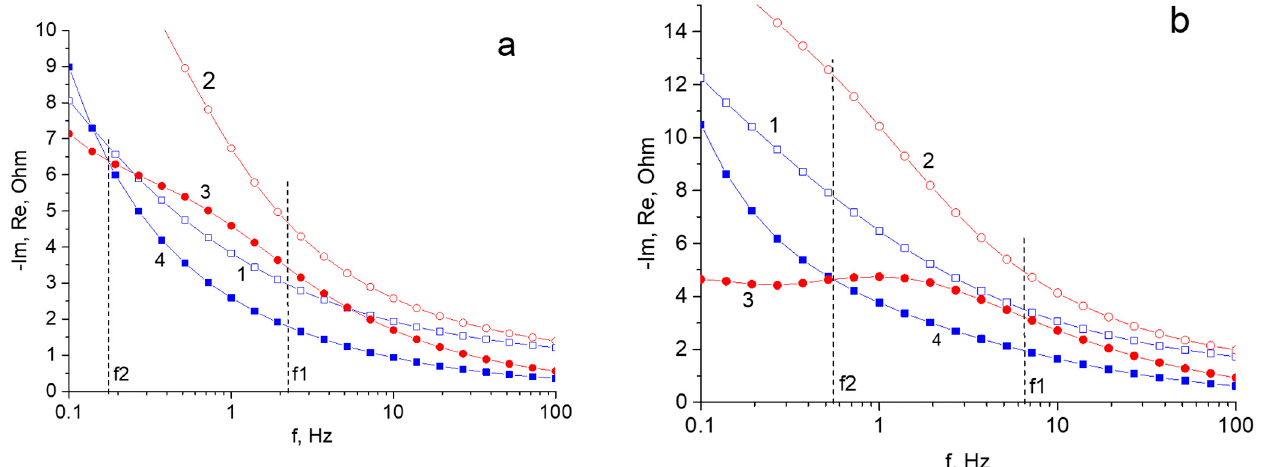
Figure 12. ( a ) Region of Bode diagram (from 100 Hz to 0.1 Hz) for the rGO/TiO 2 15% composite: 1—(Re) for the EDL region ( − 150 mV); 2—(Re) for the region of charged pseudocapacitance of TiO 2 ( − 880 mV); 3—( − Im) for the region of charged pseudocapacitance of TiO 2 ( − 880 mV); 4—( − Im) for the EDL region ( − 150 mV). ( b ) Region of Bode diagram (from 100 Hz to 0.1 Hz) for the composites of rGO/TiO 2 30%: 1—(Re) for the EDL region ( − 200 mV); 2—(Re) for the region of charged pseudocapacitance of TiO 2 ( − 900 mV); 3—( − Im) for the region of charged pseudocapacitance of ( − 900 mV); 4—( − Im) for he EDL region ( − 200 mV).